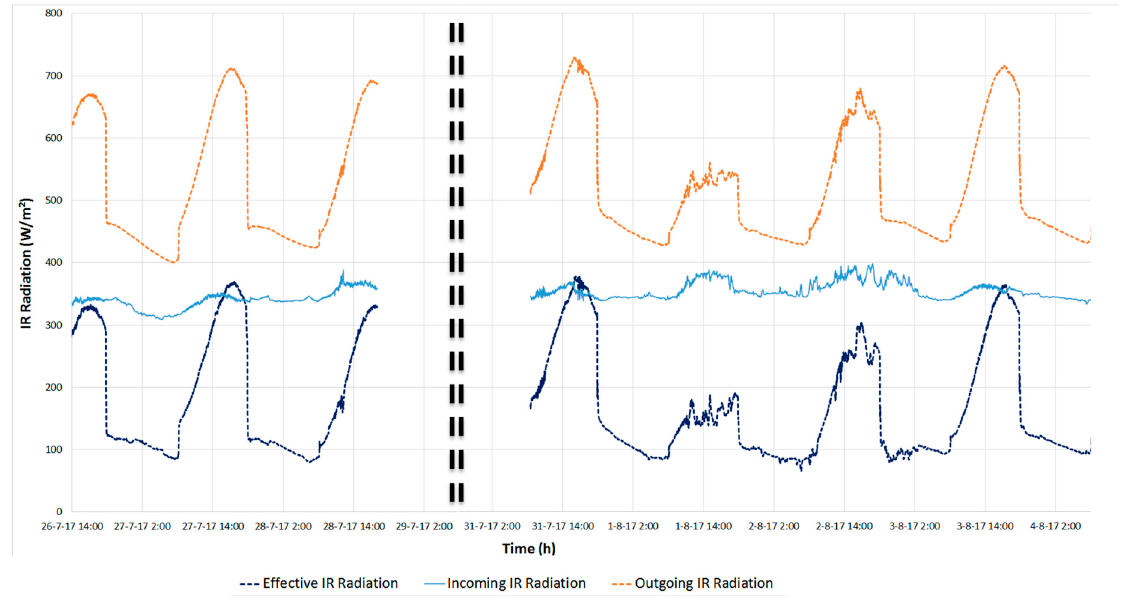
Figure 5. Incoming, outgoing and net effective radiation of the RCE concept.